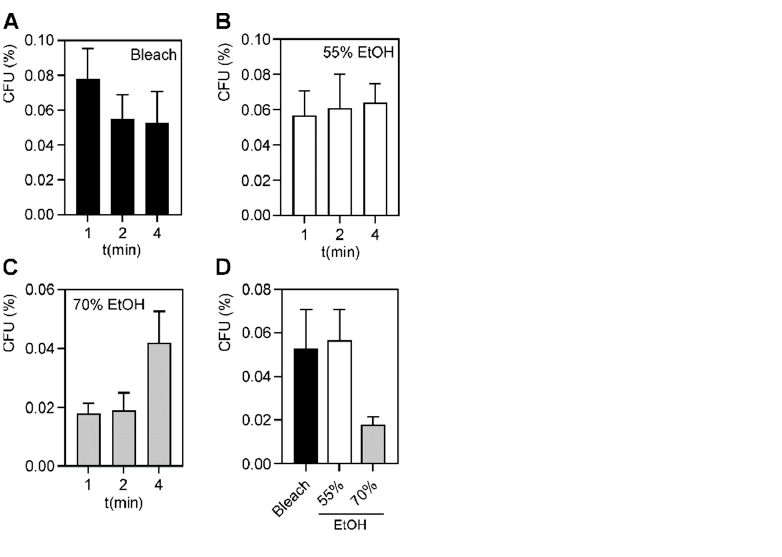
Figure 1. Survival of planktonic bacteria following germicide exposure. Average percent survival of ten planktonic A. baumannii strains, both MDR and PS strains combined, after 1-, 2-, and 4-min exposure with ( A ) 0.63% bleach, ( B ) 55% ethanol, and ( C ) 70% ethanol. ( D ) Comparison of bacterial survival at proper contact times for bleach (4 min), and 55% and 70% ethanol (1 min). A p -value of ≤ 0.05 was considered significant. The bars show mean survival among all bacterial strains, and error bars represent standard deviation. No significant differences were observed.